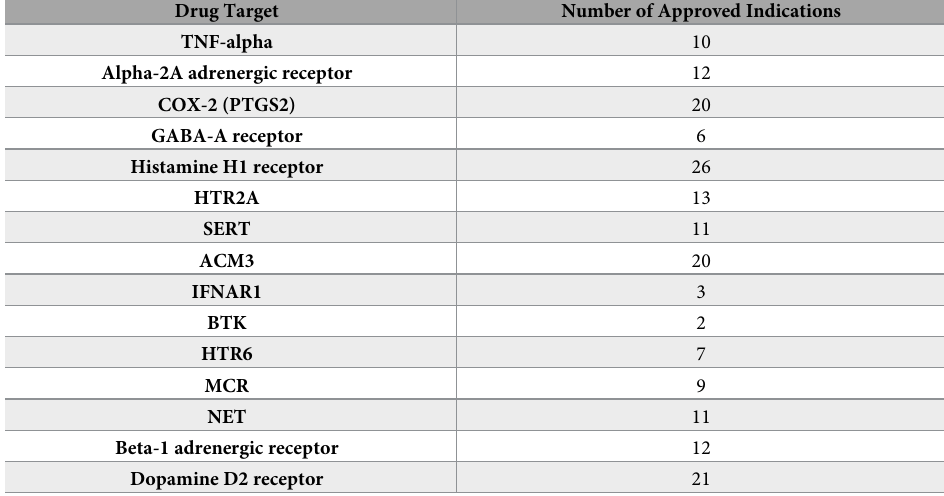
Table 1. Summarization of drug targets and their number of approved indications in